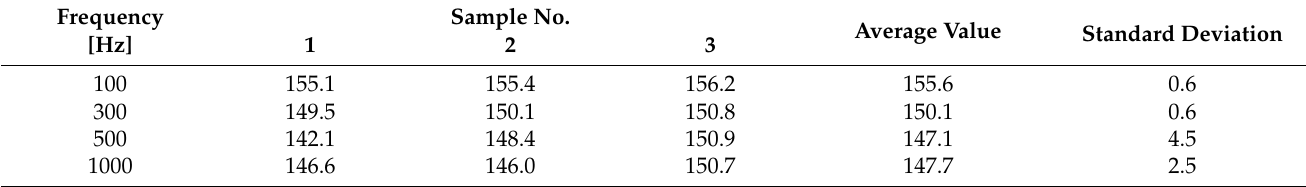
Table 11. Dynamic stiffness (dB re 1 N/m) for asphalt concrete (AC) on a concrete base course— laboratory measurements